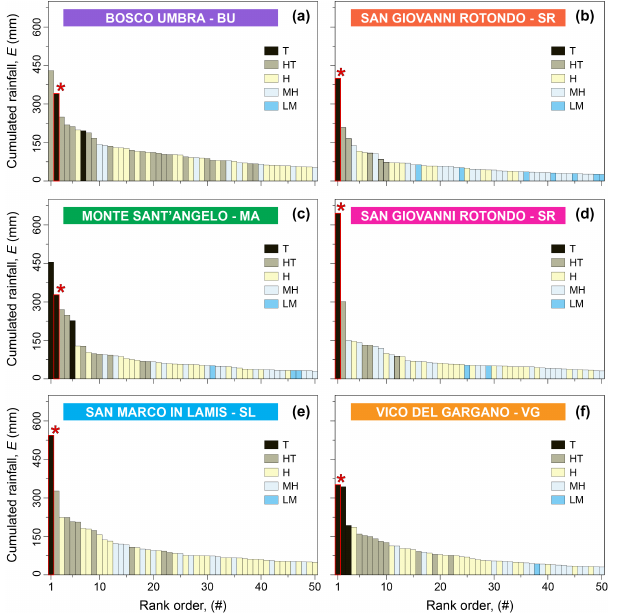
Figure 4. Rank order analysis of rainfall events in the Gargano Promontory from April 2009 to April 2016. Coloured bars show cumulated event rainfall for six rain gauges: (a) Bosco Umbra – BU, (b) Cagnano Varano – CV, (c) Monte Sant’Angelo – MA, (d) San Giovanni Rotondo – SR, (e) San Marco in Lamis – SM and (f) Vico del Gargano – VG. Bars arranged from high (left) to low (right) values. Colours identify six categories of cumulated rainfall proposed by Alpert et al. (2002). Legend: T is torrential rainfall (minimum 128mmday − 1 ) , HT is heavy– torrential (64–128mmday − 1 ) , H is heavy (32–64mmday − 1 ) , MH is moderate–heavy (16–32mmday − 1 ) and LM is light–moderate (4–16mmday − 1 ) . Black bars with red asterisks show the 1–6 September 2014 period.